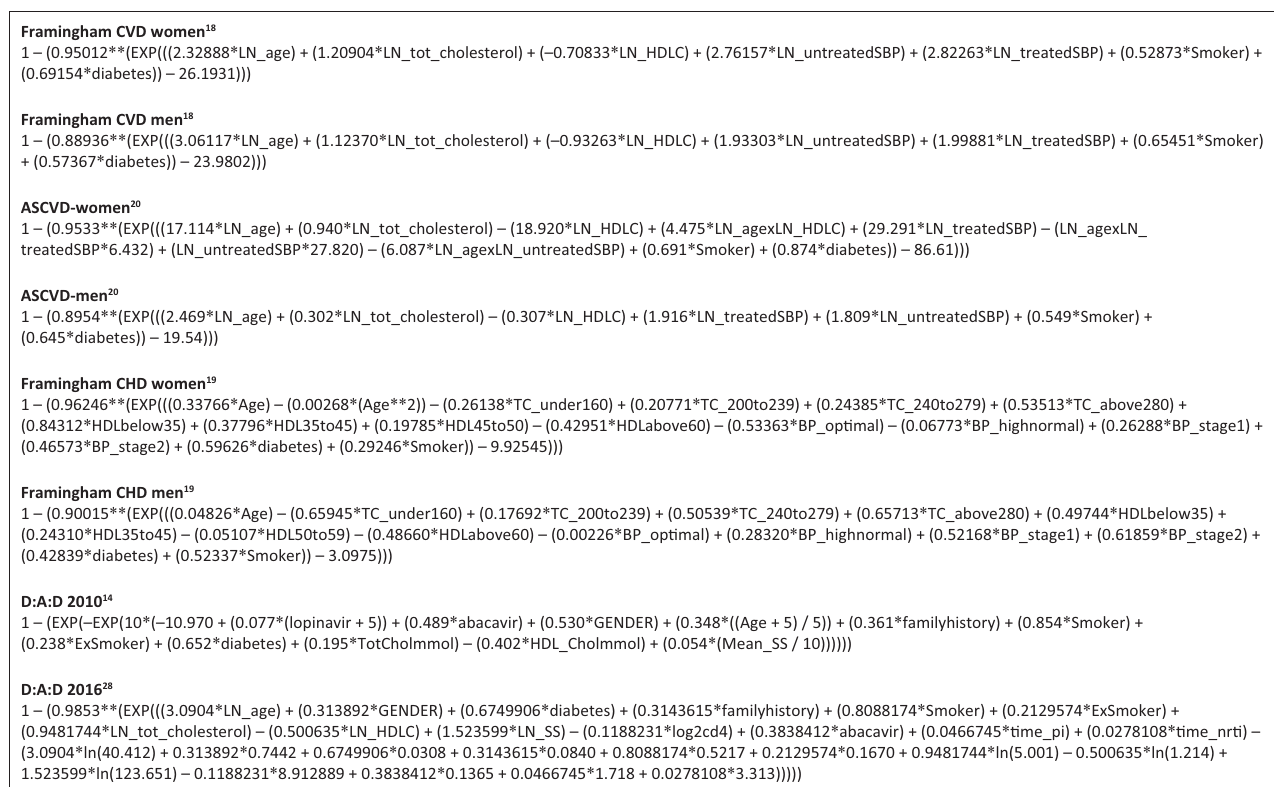
FIGURE 1-A1: Equations used to calculate individualised cardiovascular